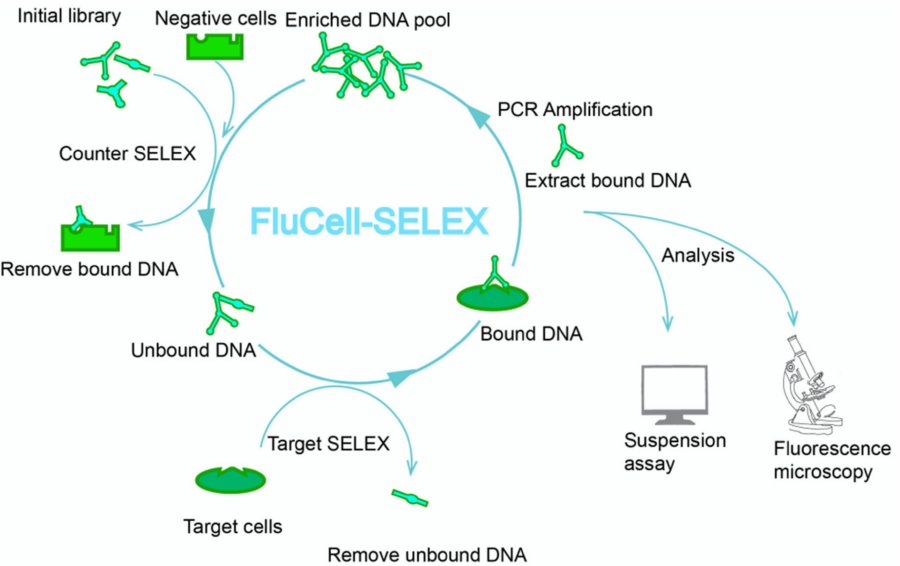
Figure 1. Directed evolution of a polyclonal aptamer library using FluCell-SELEX, which identifies R. intestinalis explicitly. Counter SELEX can focus the initial library to remove aptamers linked to control cells, a mixture of Akkermannsia muciniphila , Allobaculum stercoricanis , Blautia producta , Parabc- teroides distasonis and Rikenella microfusus . This process was implemented to increase selection pressure to improve efficiency of the molecular evolution process. The unbound aptamers were then further co-incubated with R. intestinalis in the Target SELEX to obtain aptamers that could bind to the dedi- cated target cells. This process is subsequently repeated several times with increasing harshness of the binding conditions to obtain aptamer libraries that specifically bind to R. intestinalis cells with high affinity. The aptamer libraries obtained after each round of selection were analyzed by fluorometric assays in suspension and fluorescence microscopy to determine their affinity and